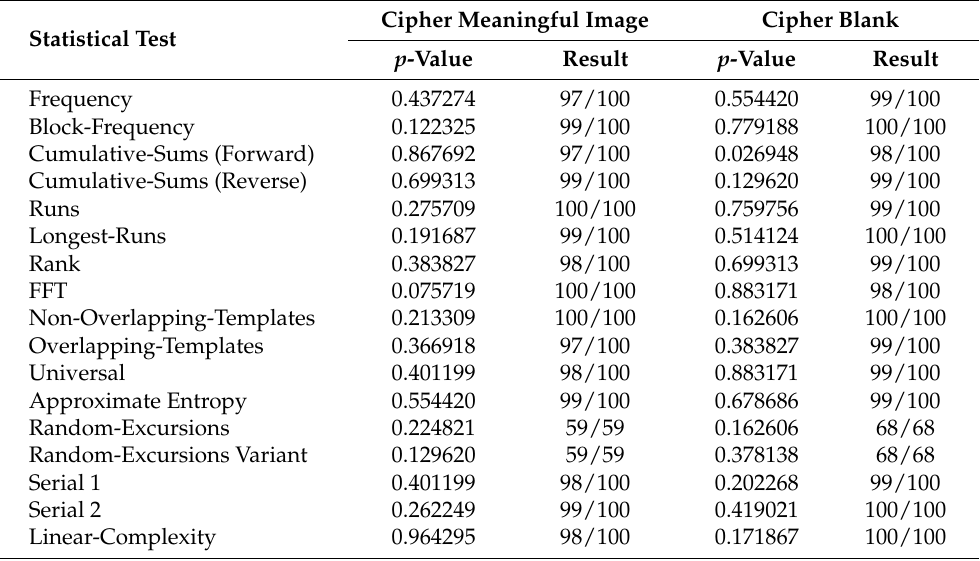
Table 5. The results of the STS [44] for two 2048 × 2048 × 3 cipher images corresponding to a meaningful image and a blank image generated by the proposed